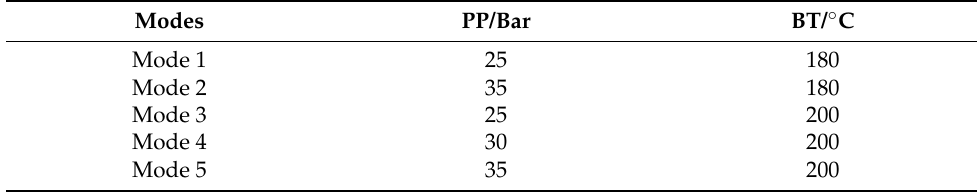
Table 1. Different operation